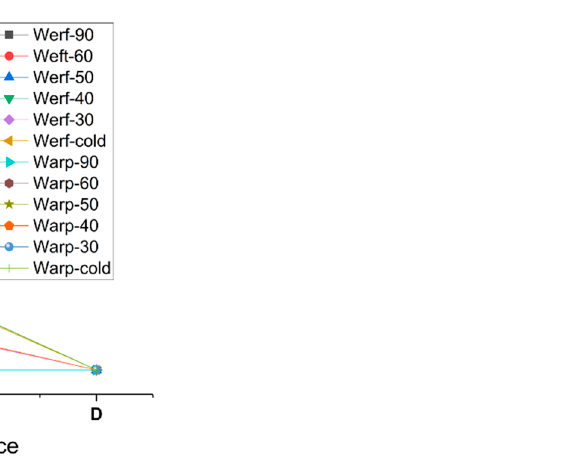
Figure 3. Shrinkage percentage for the process sequence: (A) without treatment, (B) washing and ironing, (C) oven at 130 °C/30 min, and (D) oven at 200 °C/3 min. Nomenclature: Werf/Warp ‐ wash temperature.